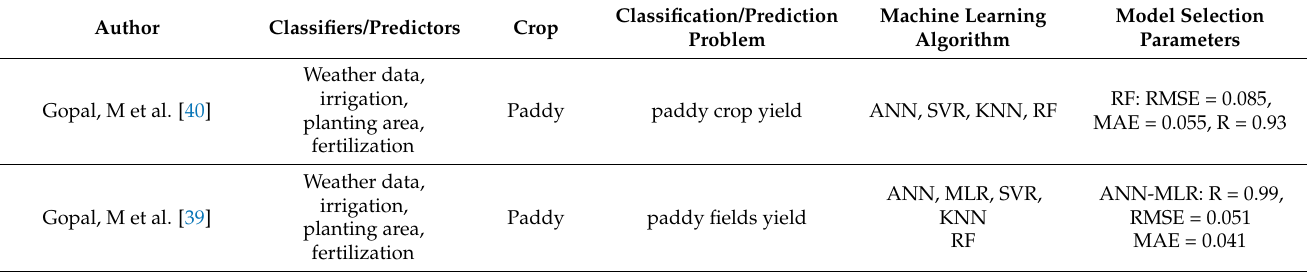
Table 2. Comparison of paddy efficiency group classification and prediction with relevant works.